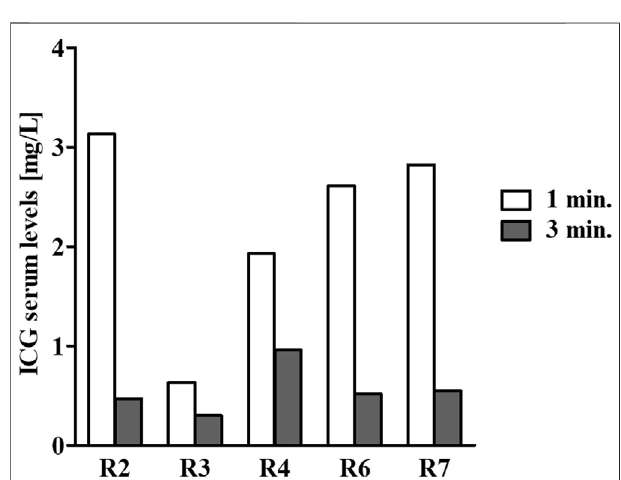
FIGURE 2 | ICG serum level determination. At the end of the continuous 11-days infusion period, 1.5 ml of 1.0 mg/ml ICG was injected via the catheter. Next, blood samples were collected from the unoccupied marginal ear vein one (white bars) and three (gray bars) minutes following an